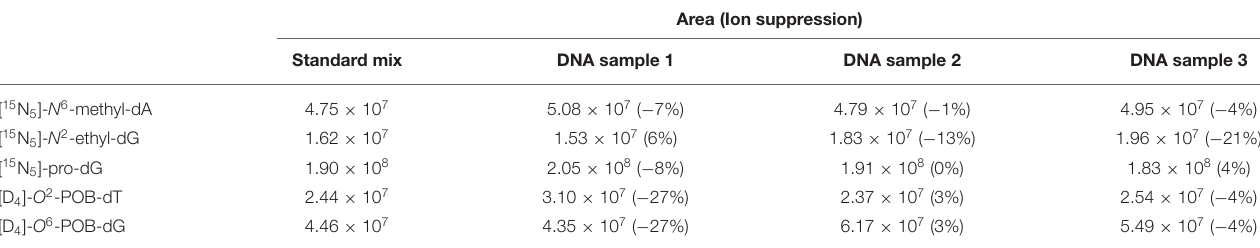
TABLE 1 | Chromatographic peak areas of the isotopically labeled standards in the neat sample and triplicate set of spiked DNA samples (final concentrations of 5 fmol/ µ L), and the calculated values of ion suppression.